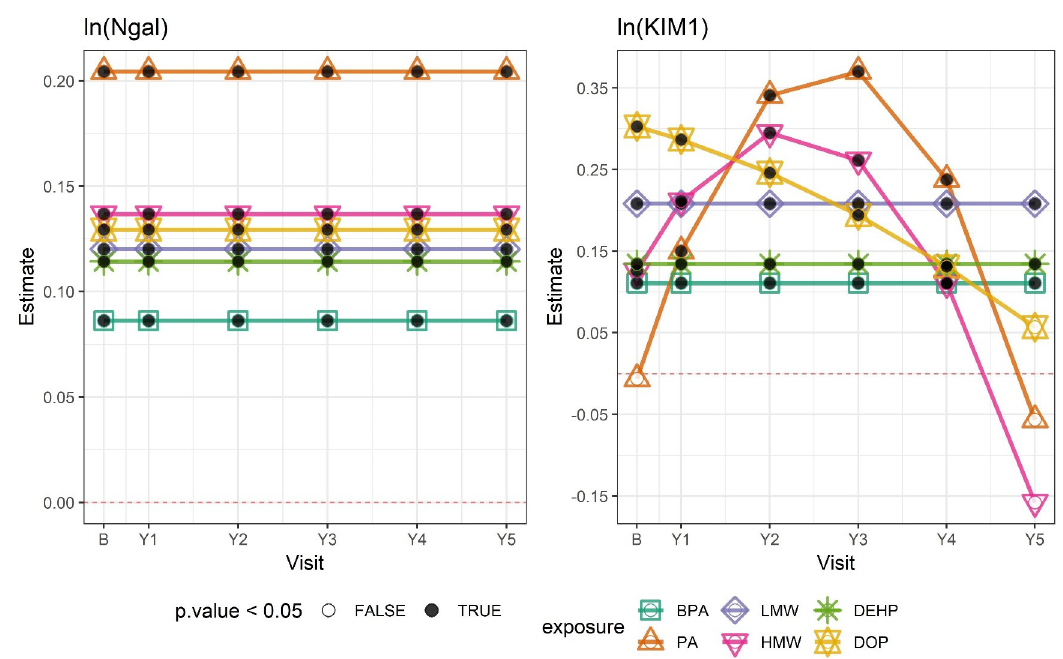
Fig 1. Associations between ln-transformed chemical exposures and ln-transformed biomarkers of tubular injury by study visit. Outcome estimates were derived from adjusted linear mixed-effects (LME) models and correspond to a 1–standard deviation change in each ln-transformed chemical exposure. Numerical estimates are shown in S3 Table. The horizontal dashed line indicates 0. Black dots indicate that the estimate had a p- value < 0.05; white dots indicate a p- value � 0.05. B, baseline; BPA, bisphenol A; DEHP, di(2-ethylhexyl) phthalate; DOP, di-n-octyl phthalate; HMW, high molecular weight phthalates; KIM1, kidney injury molecule-1; LMW, low molecular weight phthalates; Ngal, neutrophil gelatinase-associated lipocalin; PA, phthalic acid; Y[number], year